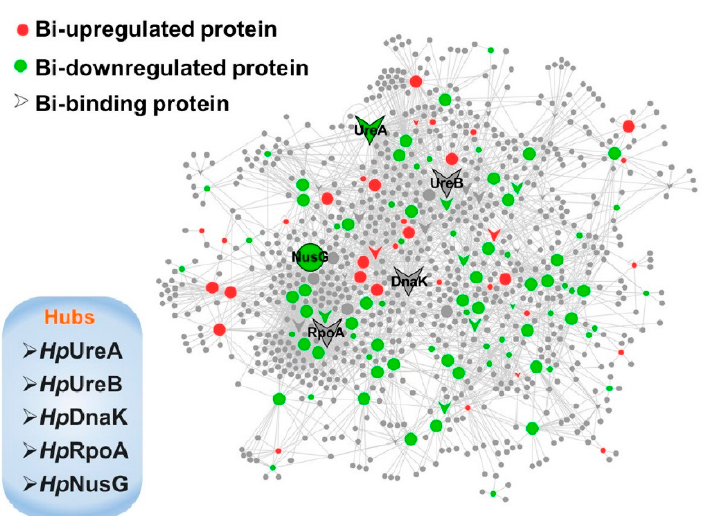
Figure 5. Schematic network depicting bismuth interaction with proteins in H. pylori. Proteins are colored and shaped according to their different properties in the network. Adapted with permission from Li et al. [69]. Copyright 2019 American Chemical Society.